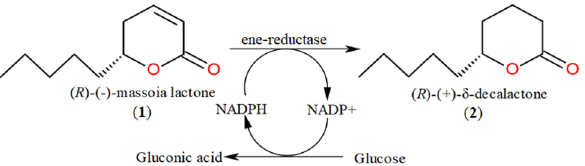
Figure 1. OYE-mediated reduction of massoia lactone (1) to ( R )-(+)-δ-decalactone